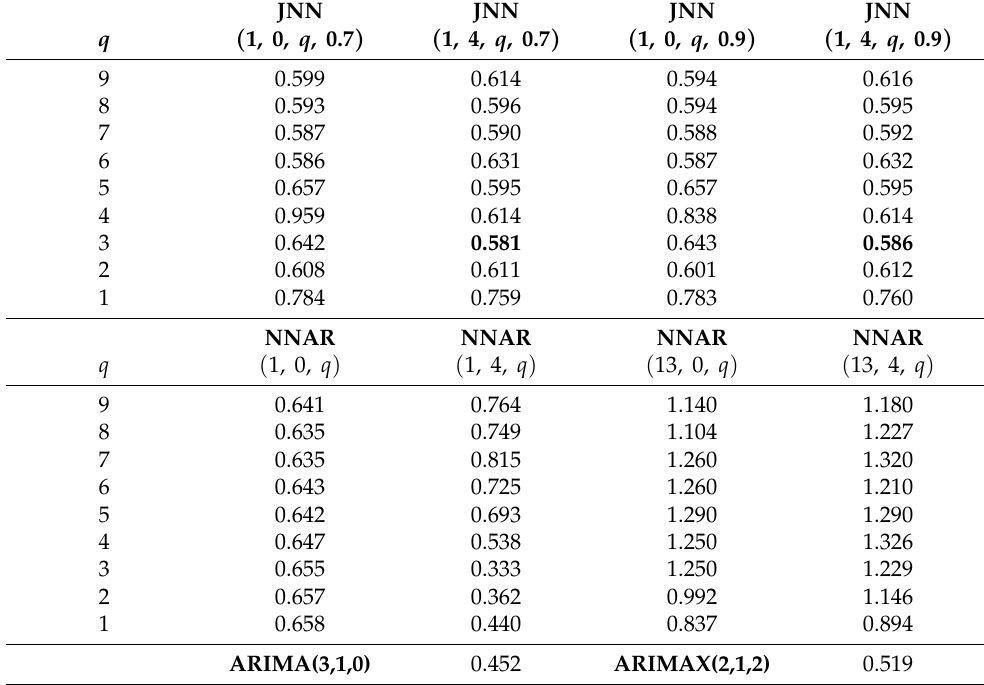
Table 4. RMSE accuracy measure “out-of-sample” for Jordan neural networks, autoregression neural networks and two ARIMA